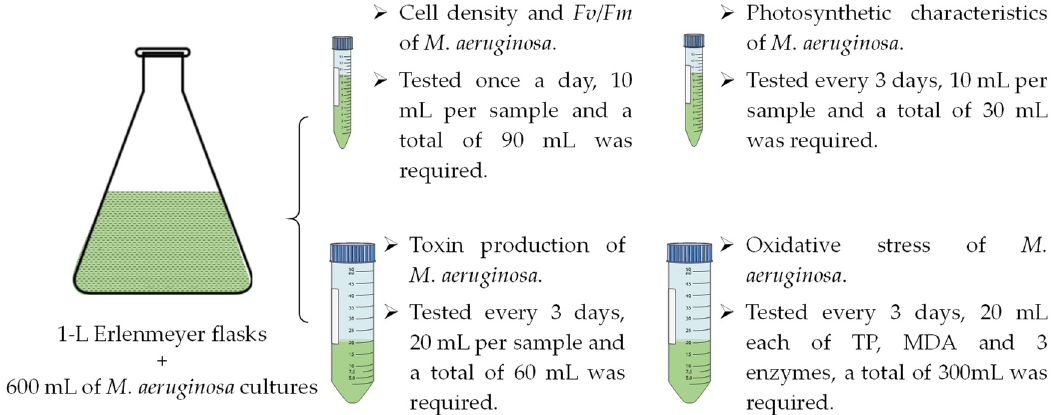
Figure 1. Culture volume for Erlenmeyer flasks and sample amount for each analysis.